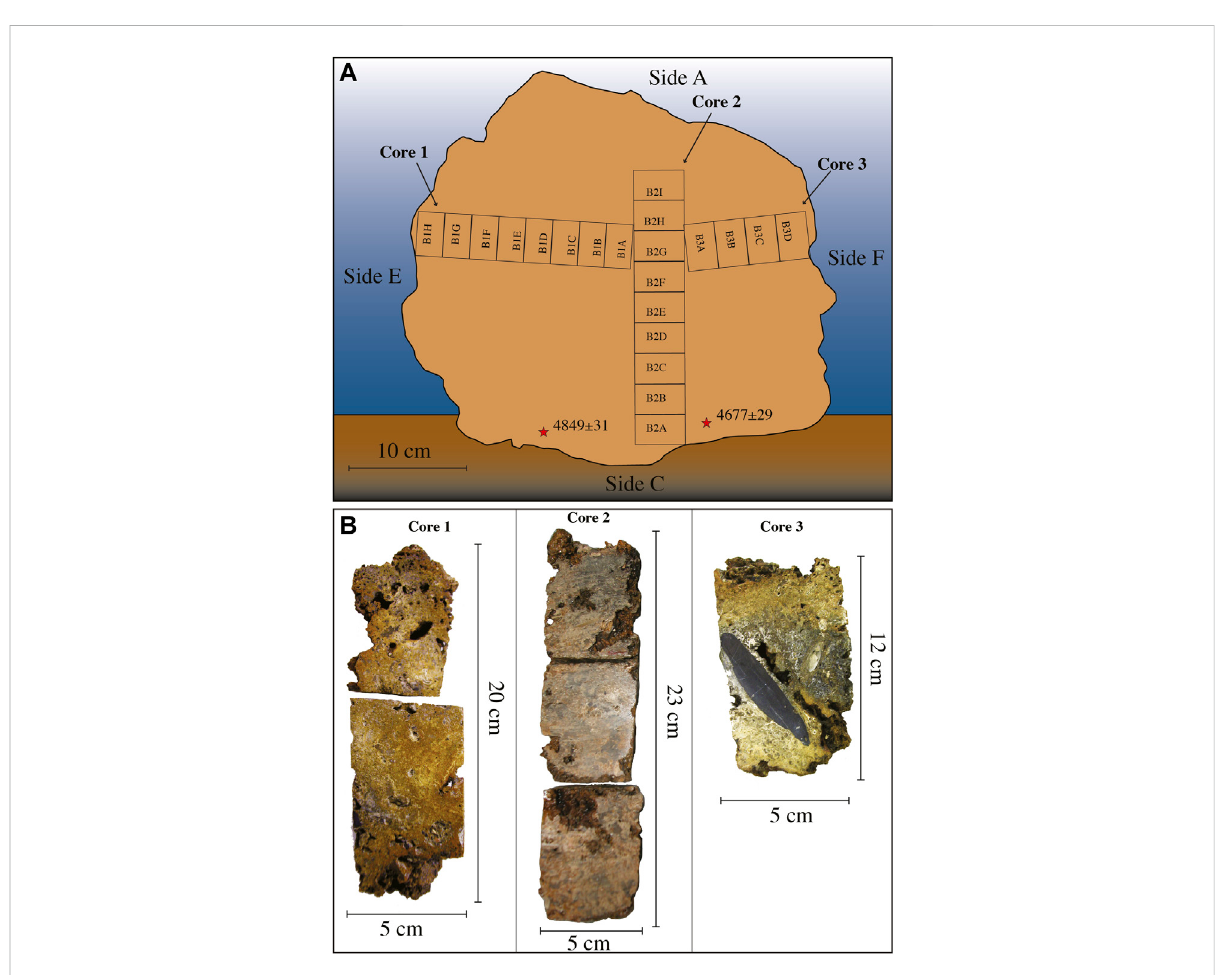
FIGURE 4 Bogliasco build-up. (A) Reconstruction of the original position with the indication of the different sides indicated by letters. The numbered rectangles indicate the position of the thin sections and the asterisks indicate the position of the dated fragments. (B) The Bogliasco cores. In core 3, note the dark layer rich in matrix and terrigenous grains, with a large